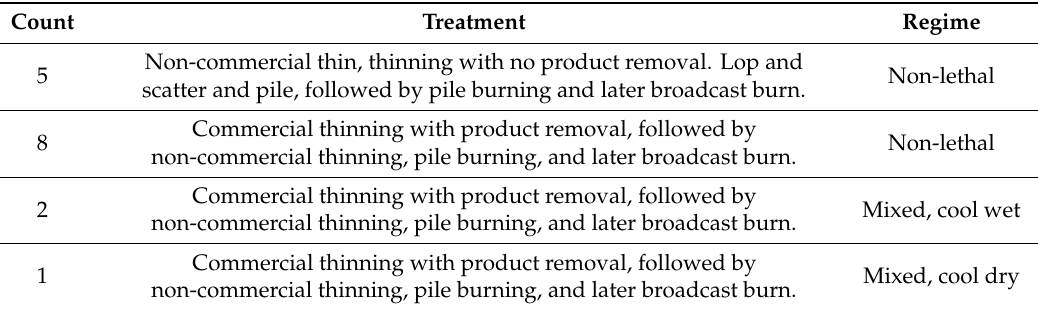
Table 2. Stand distribution among treatment type and fire regime.